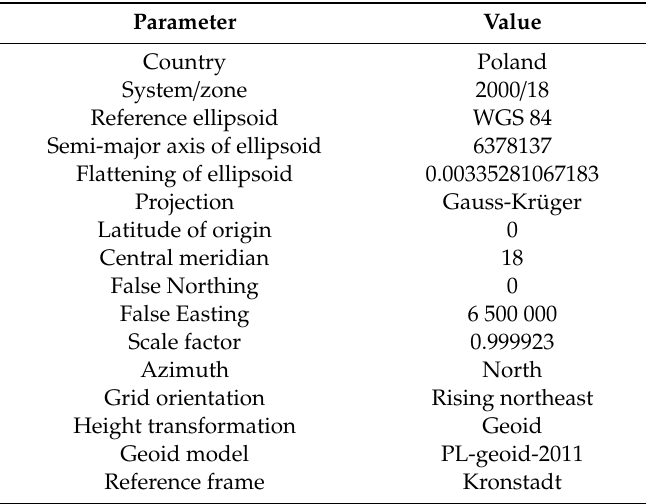
Table 1. Processing parameters during territorial sea baseline measurements in the waterbody adjacent to the municipal beach in Gdynia.